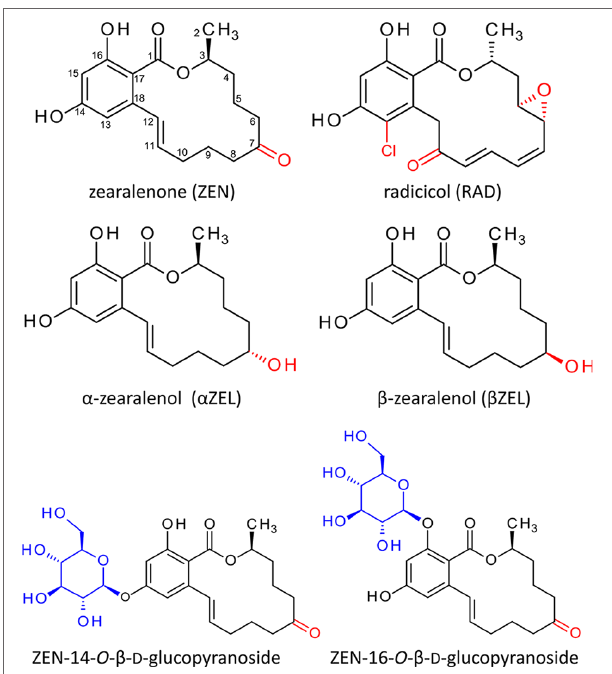
FIGURE 1 | Structures of radicicol, zearalenone (Metzler, 2011), and the zearalenone phase I metabolites α - and β -zearalenol. Structural differences are highlighted red. Below the structures of zearalenone-14- O - β -D-glucopyranoside and zearalenone-16- O - β -D-glucopyranoside. The glucosides of α -zearalenol and β -zearalenol produced in this study carry the glucose moiety at the analogous